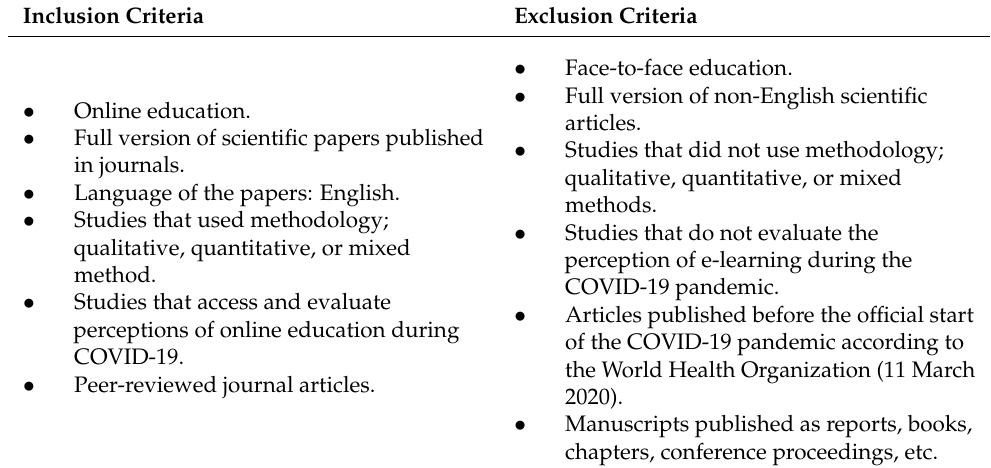
Table 1. Inclusion and exclusion